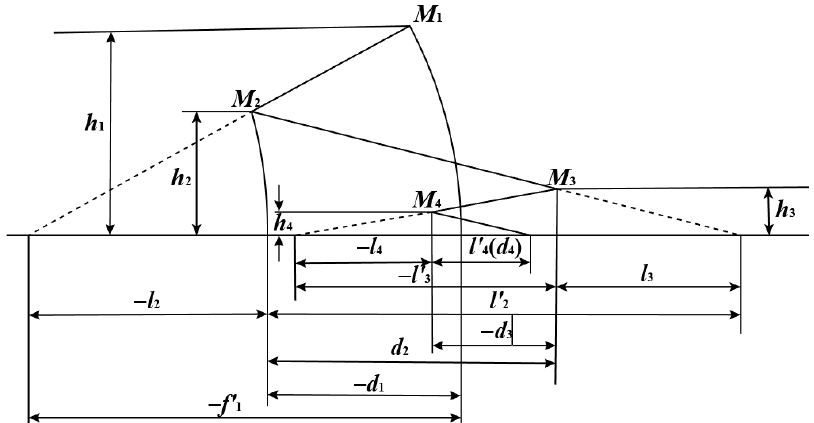
( c ) Figure 5. ( a ) Spot diagram of the fore-infrared system. ( b ) field curvature of the different wave- lengths. ( c ) distortion of the different wavelengths. 3.3. Rear-Polarization System When the pixel-level polarization sensor and the fore-infrared system are deter-